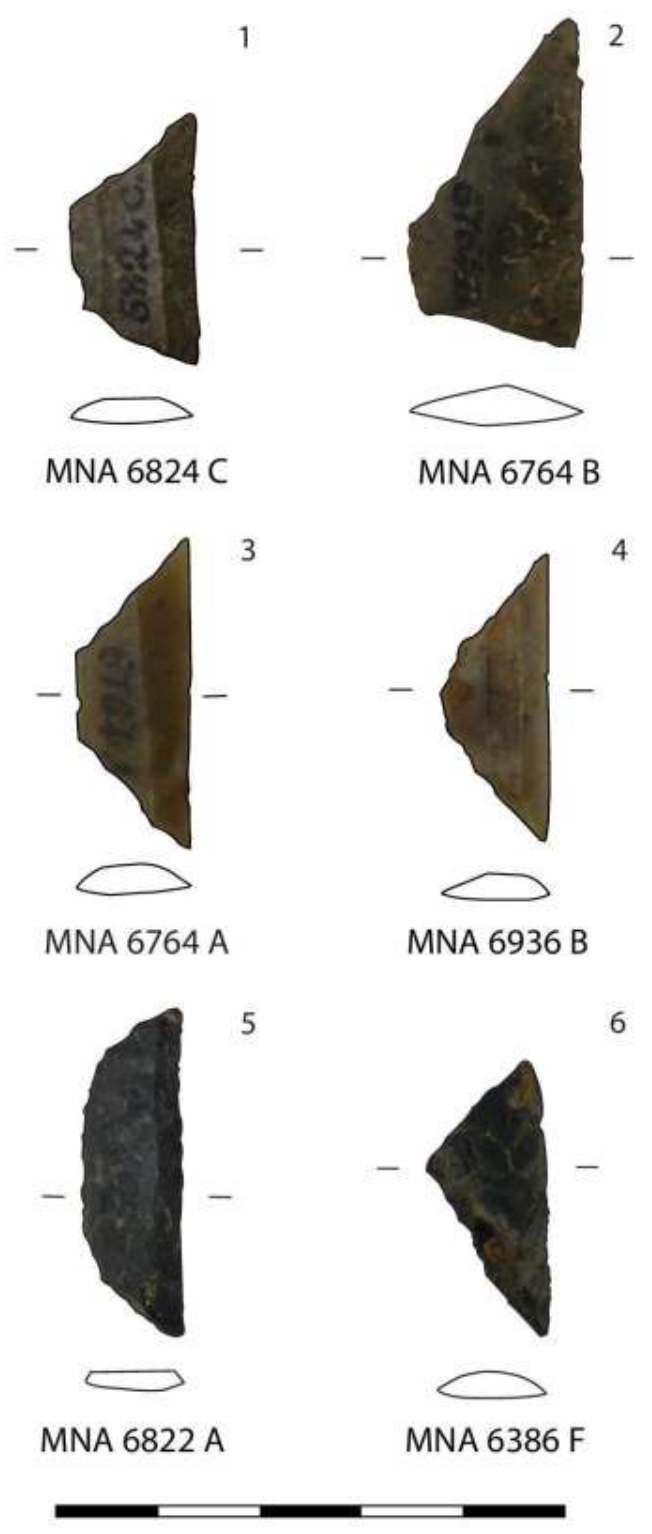
Figure 10. Geometric armatures subtypes. 1-2: Asymmetric trapezoid with straight or slightly concave truncations; 3-4: Symmetric trapezoid with straight or slightly concave truncations; 5: Elongated symmetric segment; 6: Scalene triangle. The scale bar is 5 cm long (in 1 cm